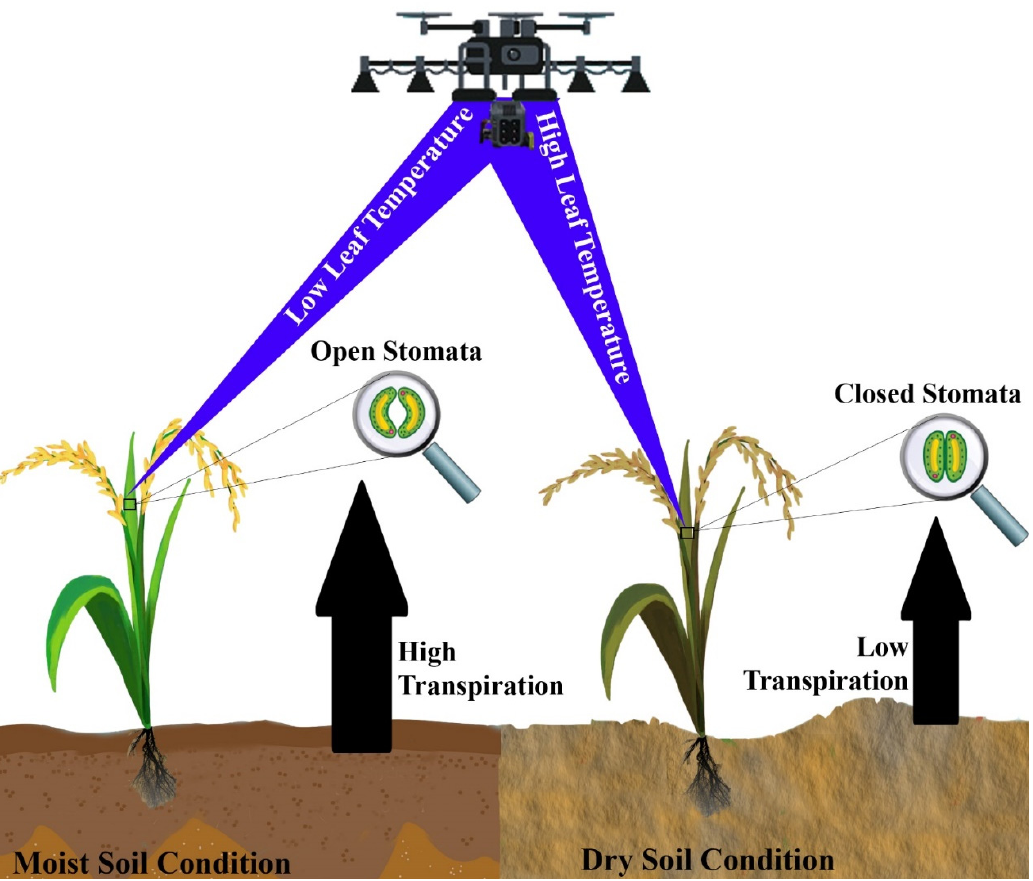
Figure 3. Remote-sensing estimation of the crop water stress using leaf transpiration, temperature, cooling, and heating effects, and comparing it with the air and soil moisture levels.